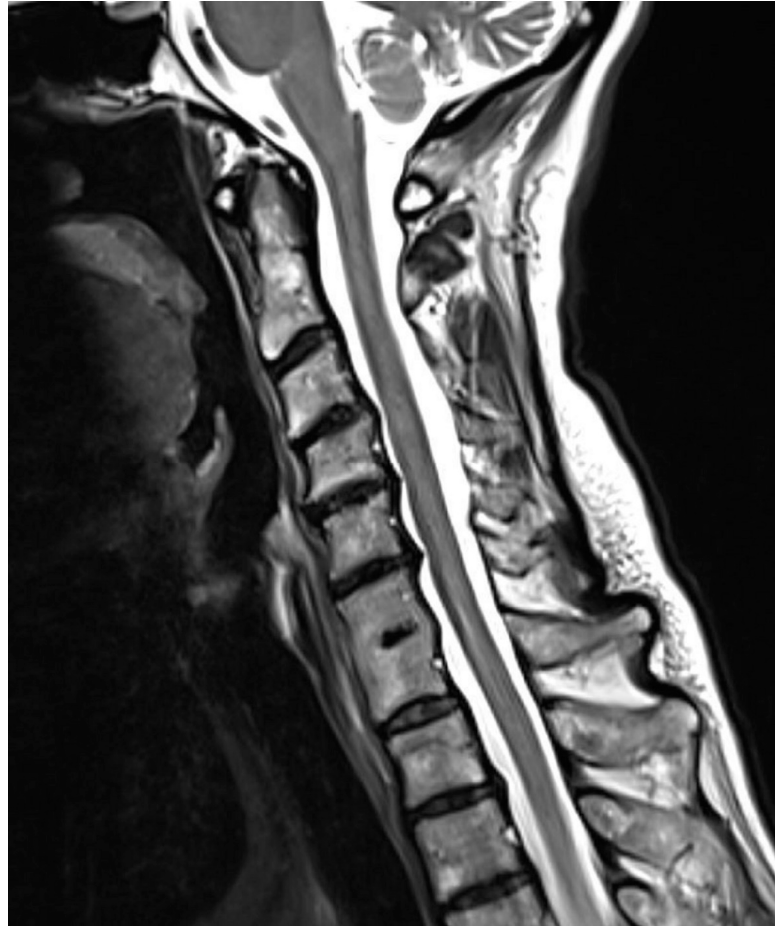
Figure 3. Sagittal T2-weighted fast spin-echo sequence; 59 y/o female; congenital block vertebra C6/7 with degenerative changes in segments C3/4, C4/5, and C5/6 (disk prolapse); however, the segment C7/Th1 is not affected by degeneration, representing a combination of ASDI in one segment and natural degenerative changes. The degeneration score in this patient, who has degeneration in seg- ments C3/4 and C4/5 but not in segments C1/2 and C2/3, is 2 (1 point per segment for loss of height of the intervertebral disk, disk bulging over the dorsal level, and evidence of retrospondylophytes). The respective degeneration ratio is 0.167 (2/12). The degeneration score for the adjacent segments in this patient, who has degeneration in segment C5/6 but not in segment C7/Th1, 1 (loss of height of the intervertebral disk, disk bulging over the dorsal level, and evidence of retrospondylophytes). The adjacent segment ratio is 0.167 (1/6). Consecutively, the instability ratio is 0 (0.167–0.167), which means that the natural degeneration and the degeneration caused by the block vertebra are equal. The adjacent segment ratio was significantly higher ( p < 0.05), measuring 0.307, com- pared to the degeneration ratio, which measured 0.188 (Table 3).